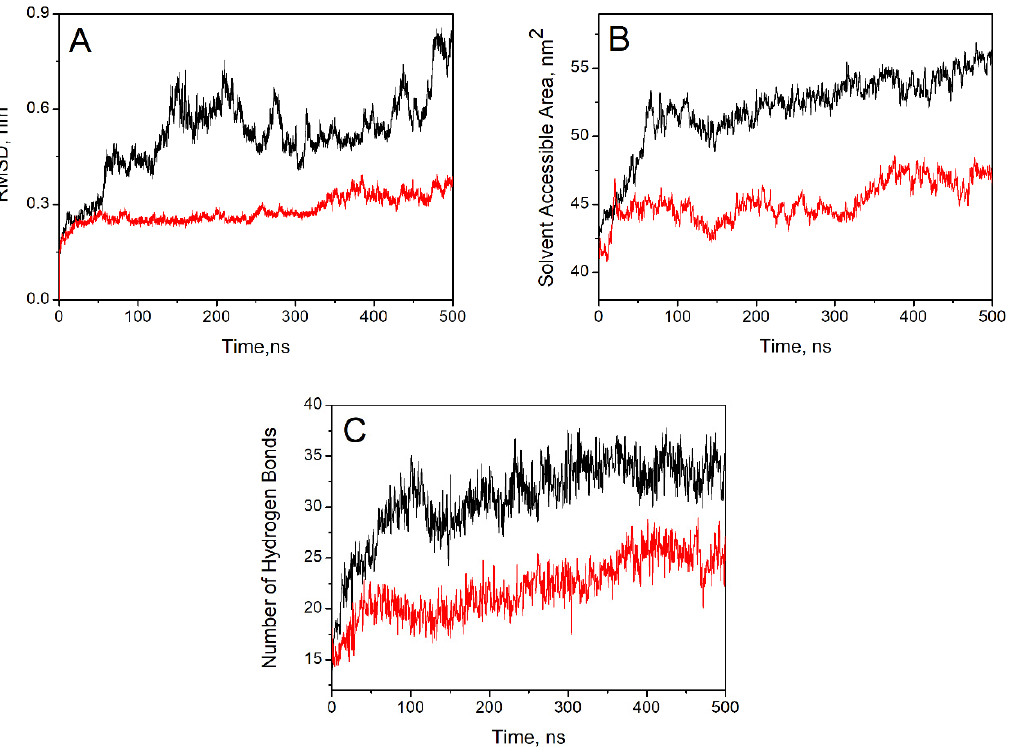
Figure 7. Dependence of MD-derived parameters on the length of simulation time for mixtures of DMSO with BuMeImAcO (black curves) and AlBzMe 2 NAcO (red curves). Part ( A ) shows the root mean square deviation (RMSD) curves. Part ( B ) shows the variation of SASA of the SF crystal during the simulations. Part ( C ) shows the number of hydrogen bonds between the SF crystal (acting as donor) and acetate ions, acting as receptors.